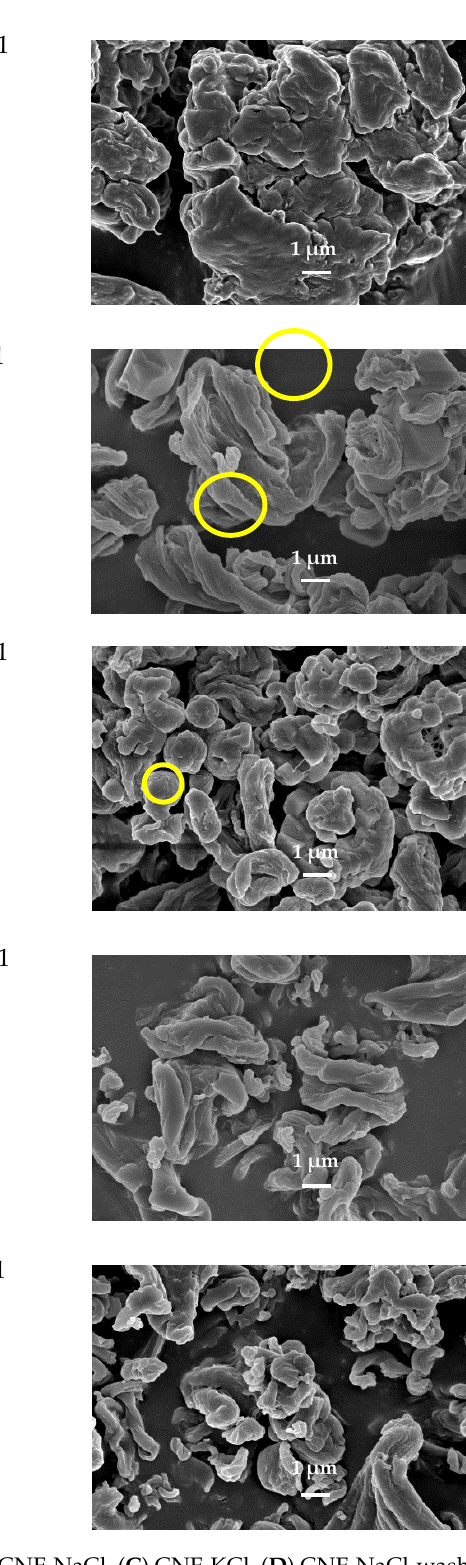
Figure 2. FE-SEM images of spray-dried CNFs samples ( A ) CNF, ( B ) CNF-NaCl, ( C ) CNF-KCl, ( D ) CNF-NaCl-wash, ( E ) CNF-KCl-wash. The images on the right side represents higher magnification. Yellow circle indicates the salt crystal.